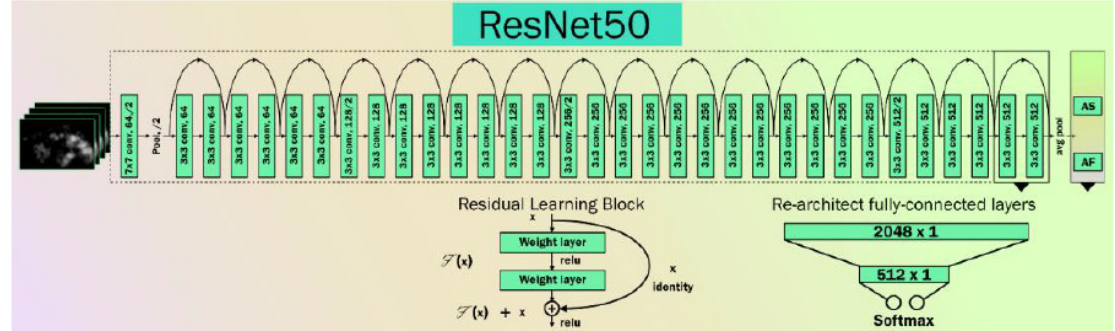
Figure A5. The general structure of Resnet50 architecture [44].